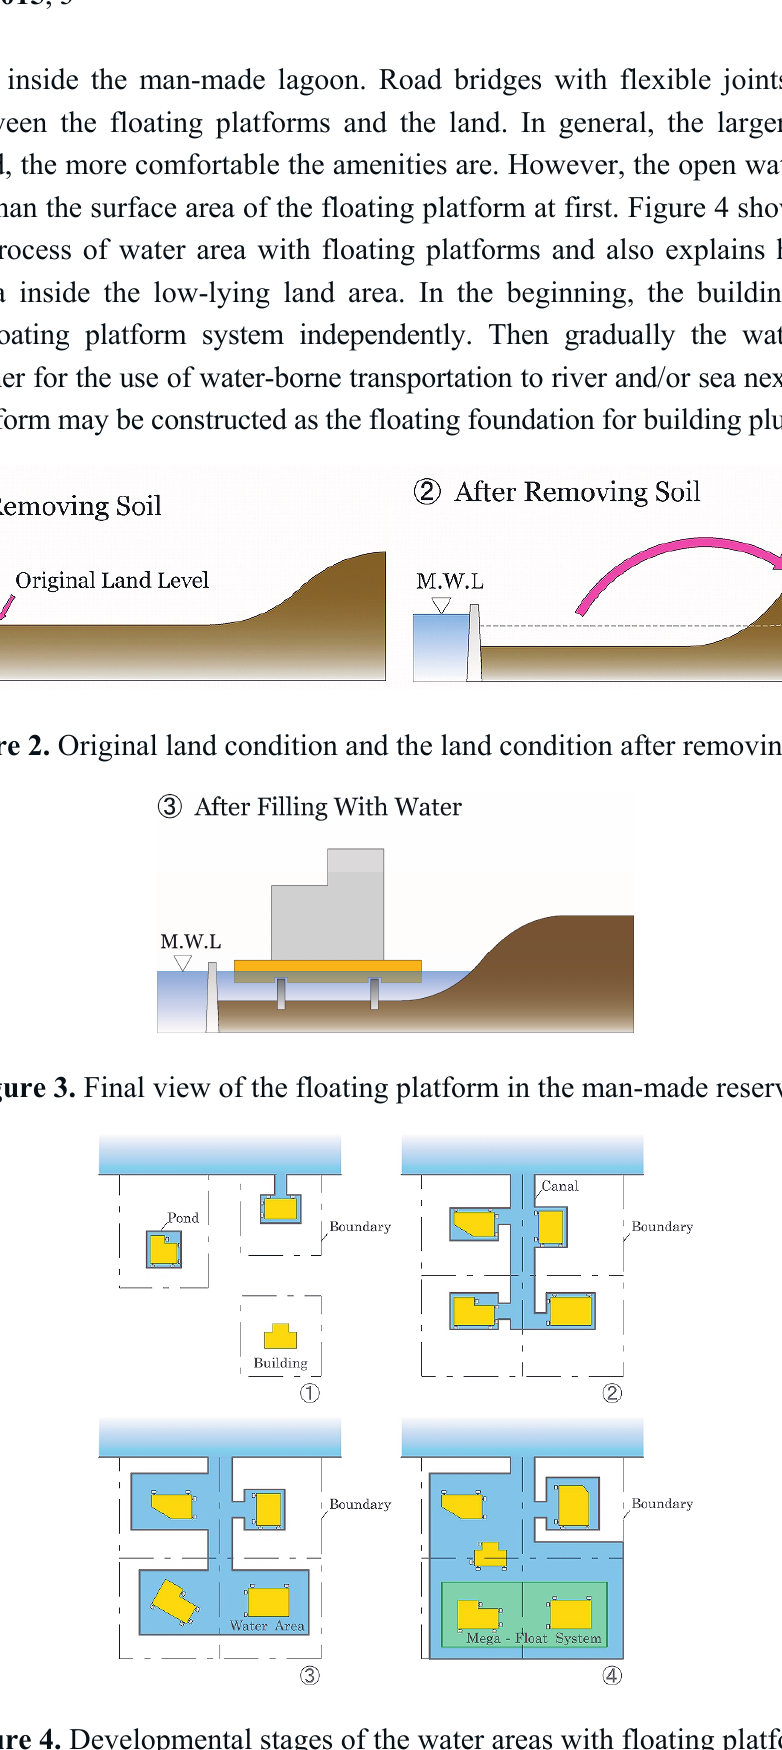
Figure 4. Developmental stages of the water areas with floating